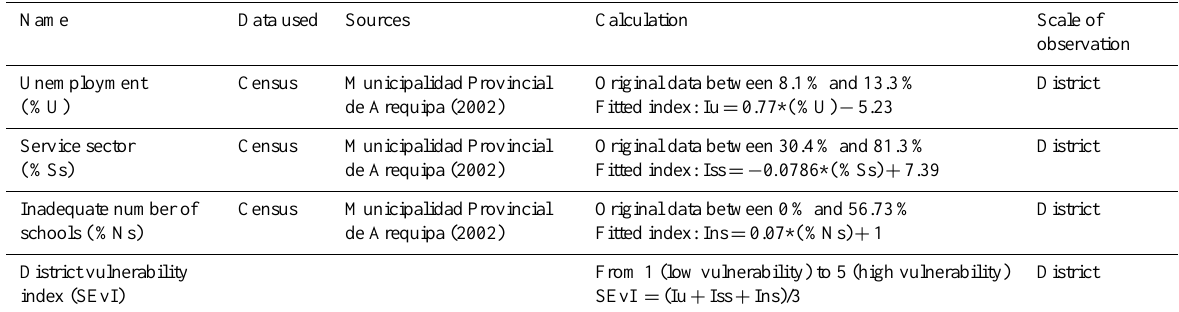
Table 5. Evaluating the socio-economic vulnerability. The measure of socio-economic vulnerability is carried out at the district scale, which is the lowest administrative division in Arequipa. However, this scale offers much less precision than that for the city-block scale. Original data (unemployment, access to public services, and inadequate number of schools) is fitted to build a global vulnerability index (SEvI) scaled from 1 to 5. The map of socio-economic vulnerability for the whole city of Arequipa is shown in Fig.